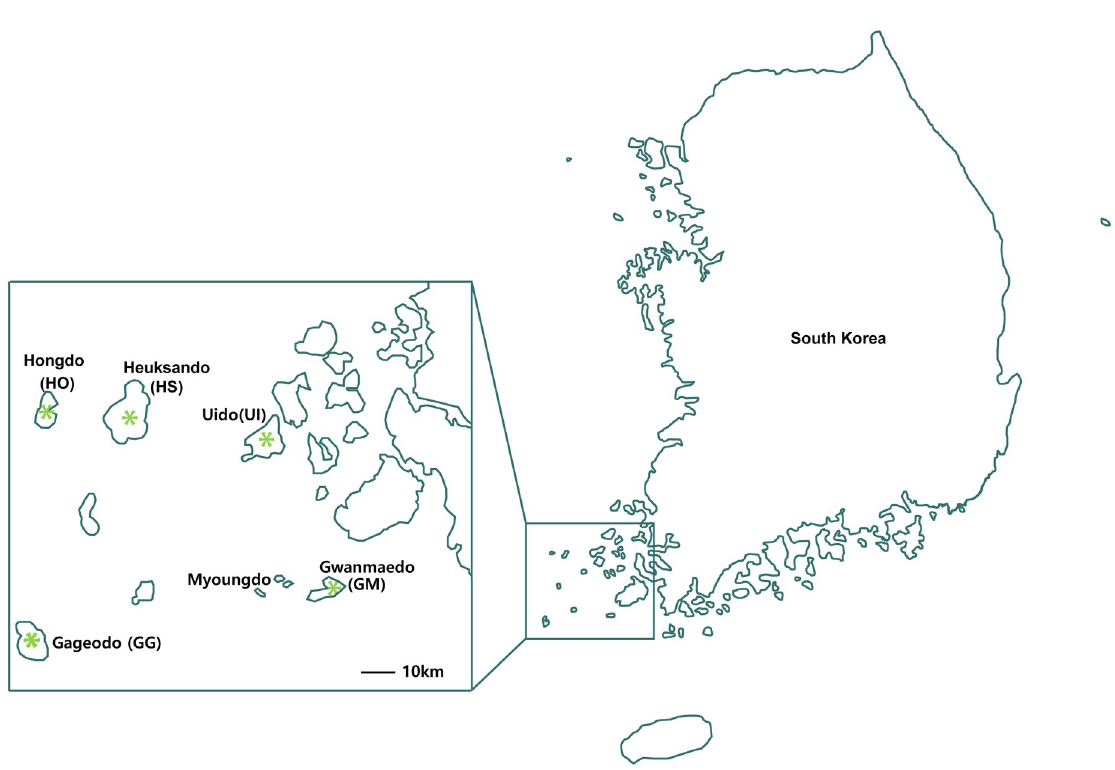
Fig 2. Distribution map of Saussurea polylepis . Collection sites are marked with the asterisk. The source of the original map image: SEDAC (Socioeconomic Data and Applications Center), http://www.worldofmaps.net/, accessed November 21, 2020.